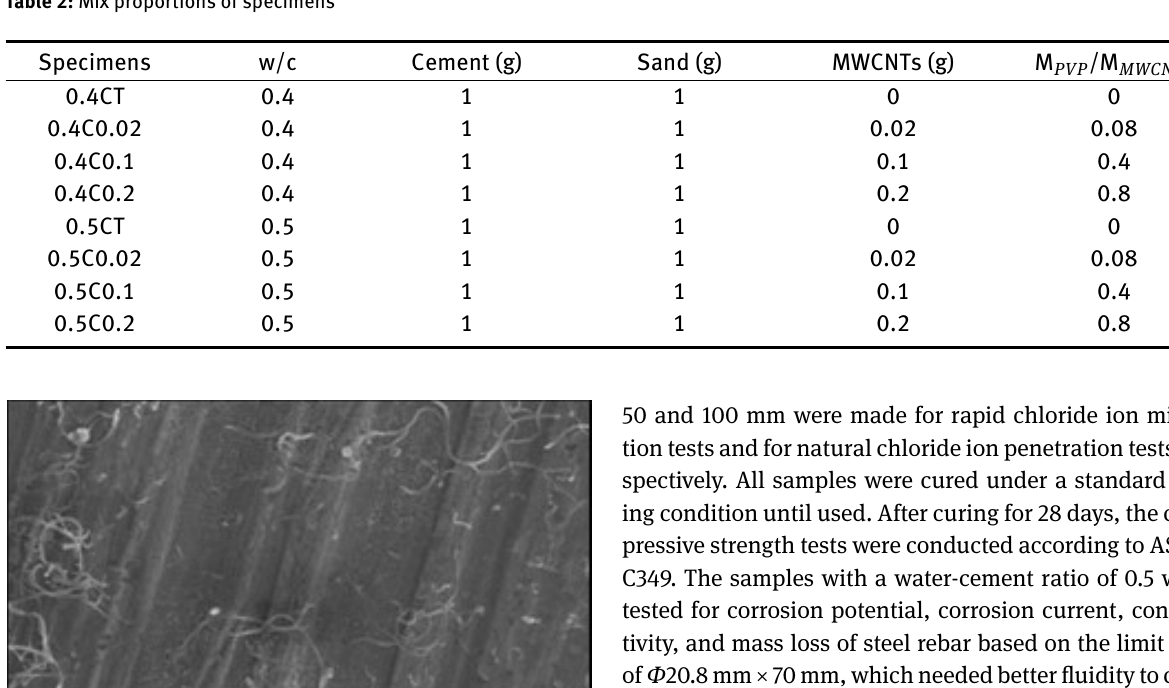
Table 2: Mix proportions of specimens